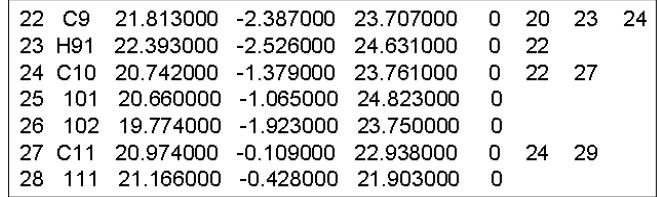
Figure 6: The incorrect XYZ file of arachidonic acid generated by the pdbxyz